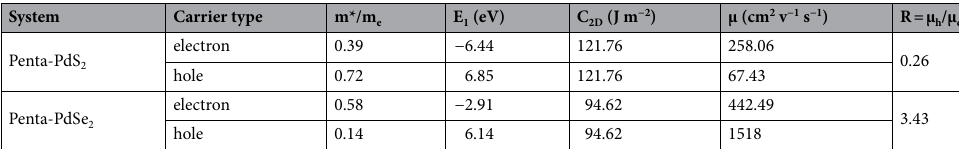
Table 2. The carrier effective mass | m *| (m e , the mass of free electrons), deformation potential constant E 1 (eV), stiffness constant C 2D (J m −2 ), carrier mobility (μ) for electron (e) and hole (h) and carrier mobility ratio (R ) along biaxial direction of penta-PdQ 2 monolayers at 300 K.